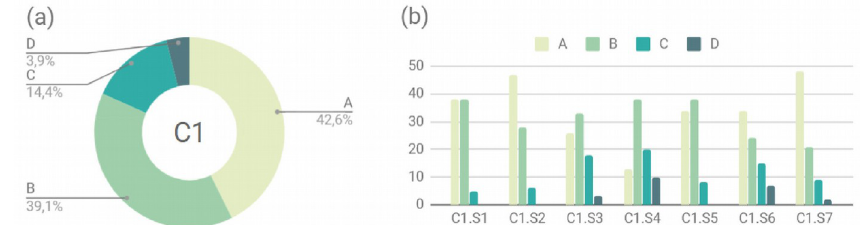
Figure 5. Student assessment of category C1. Acquiring Knowledge (a) as a whole and (b) for each question. Table 3 shows the coding of the